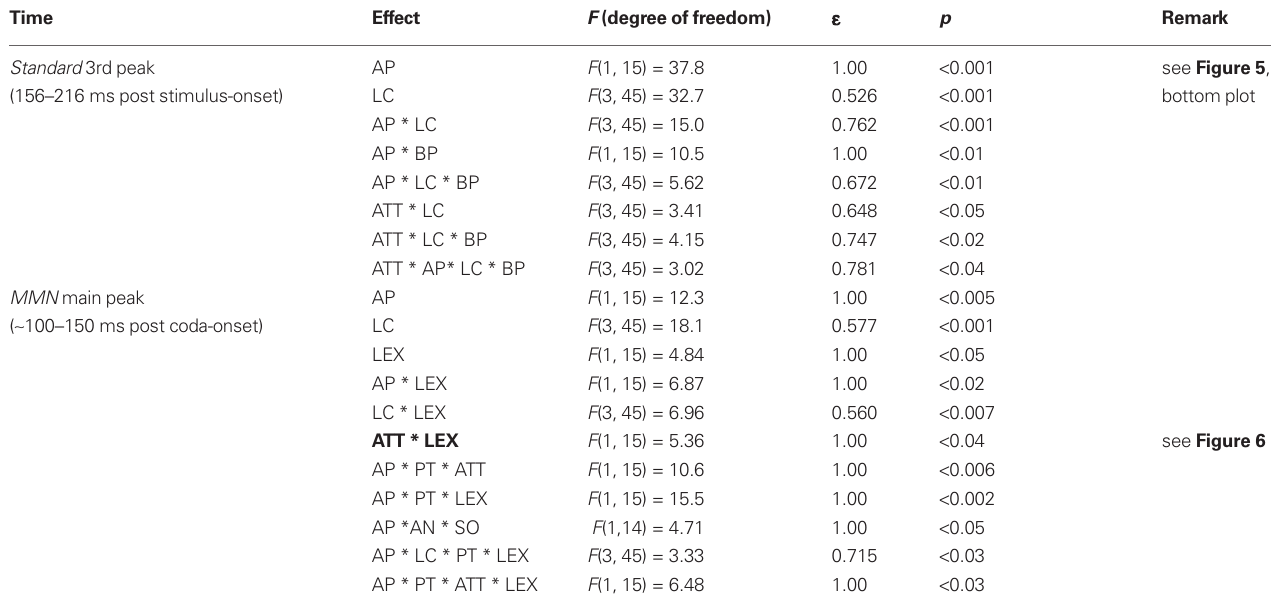
Table 2 | Statistical results: local magnetic gradient vector strengths at 8 high-amplitude loci (see Figure 4). Legend: ATT = Attention; LEX = Lexicality; PT = coda stimulus ([p], [t]); BP = CV stimulus ([baj], [paj]); AP = anterior-posterior; LC = laterality; SO = session order; ε = Greenhouse-Geisser’s epsilon ( p was corrected if Mauchly’s test indicated non-spherical